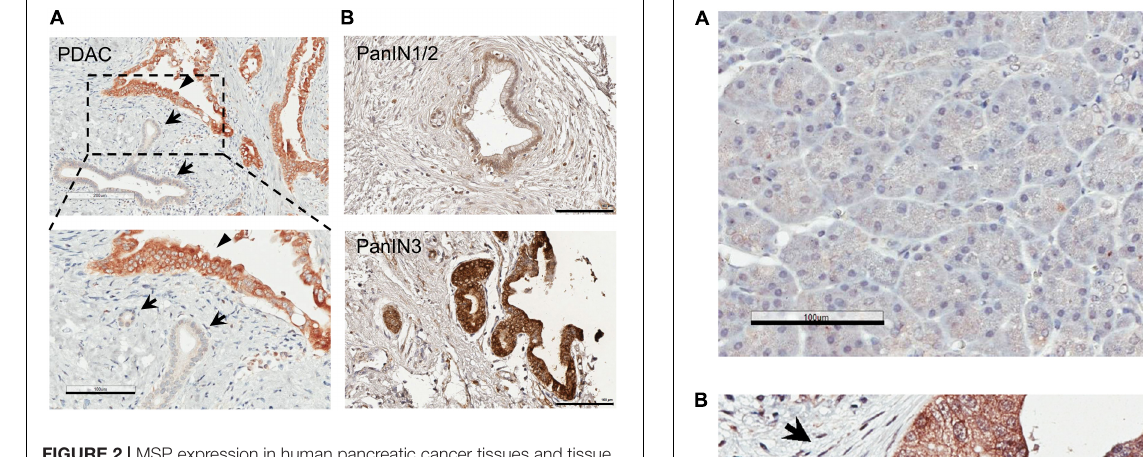
2 of 2 PanIN3), which indicates that upregulation of matriptase probably occurs earlier than that of